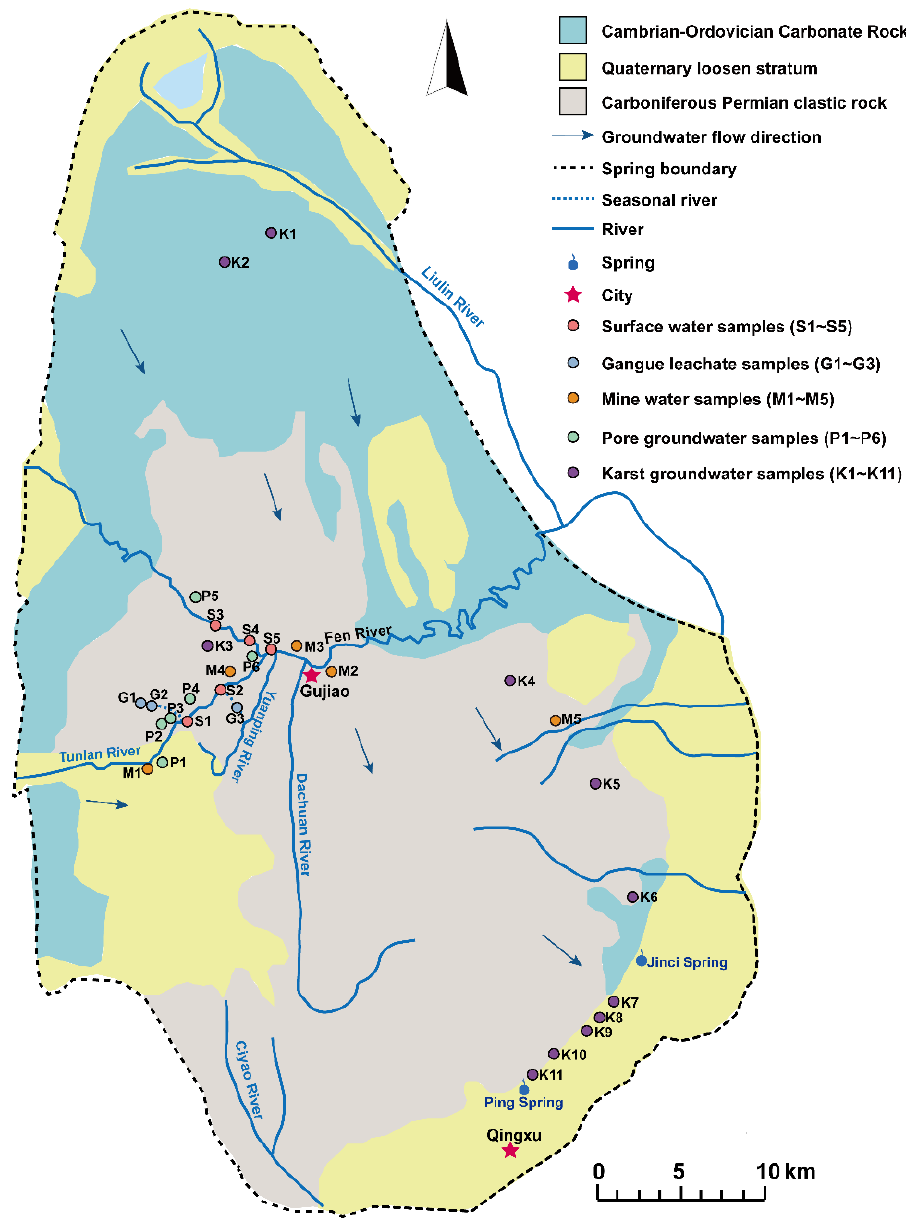
Figure 1. Study area and sampling sites.